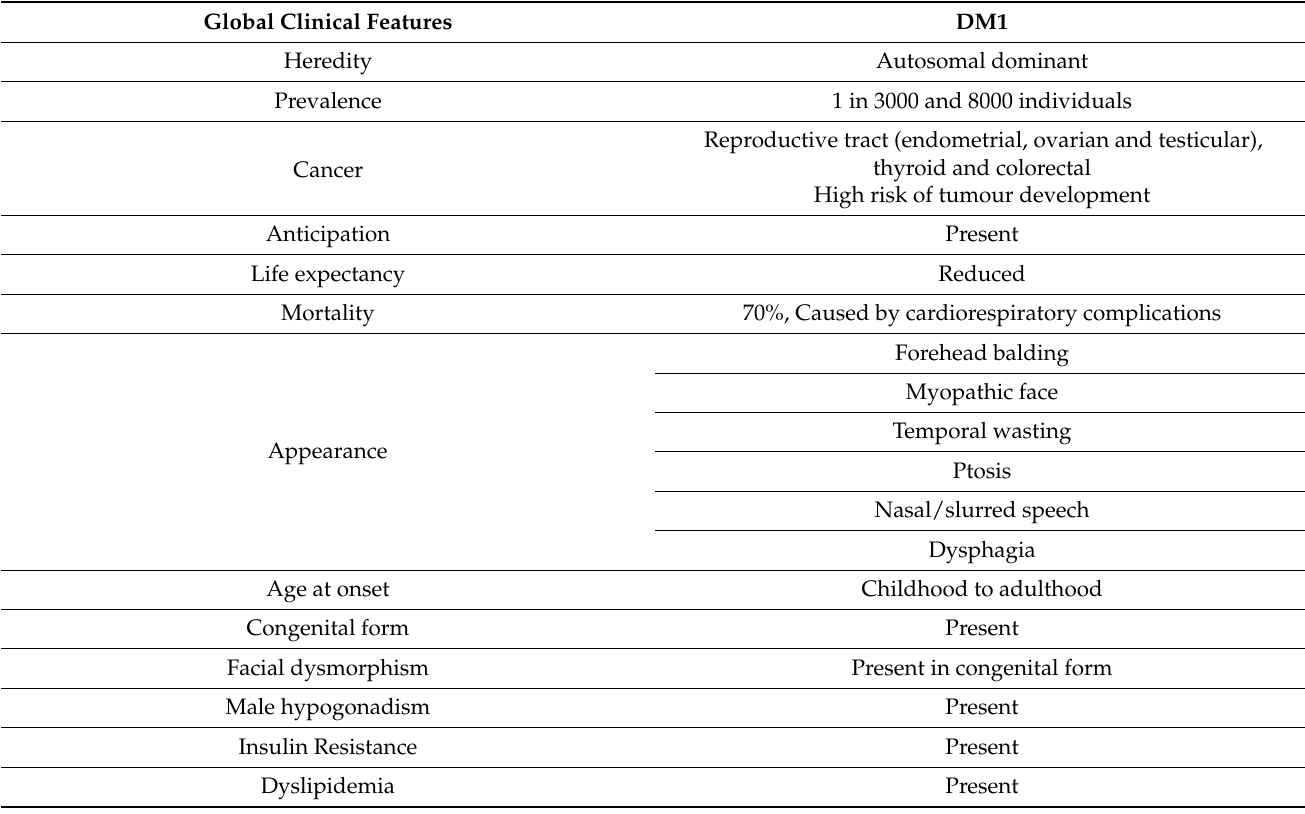
Table 1. Summary of principal clinical features of DM1 [1,2,7,15,16,19]. Global Clinical